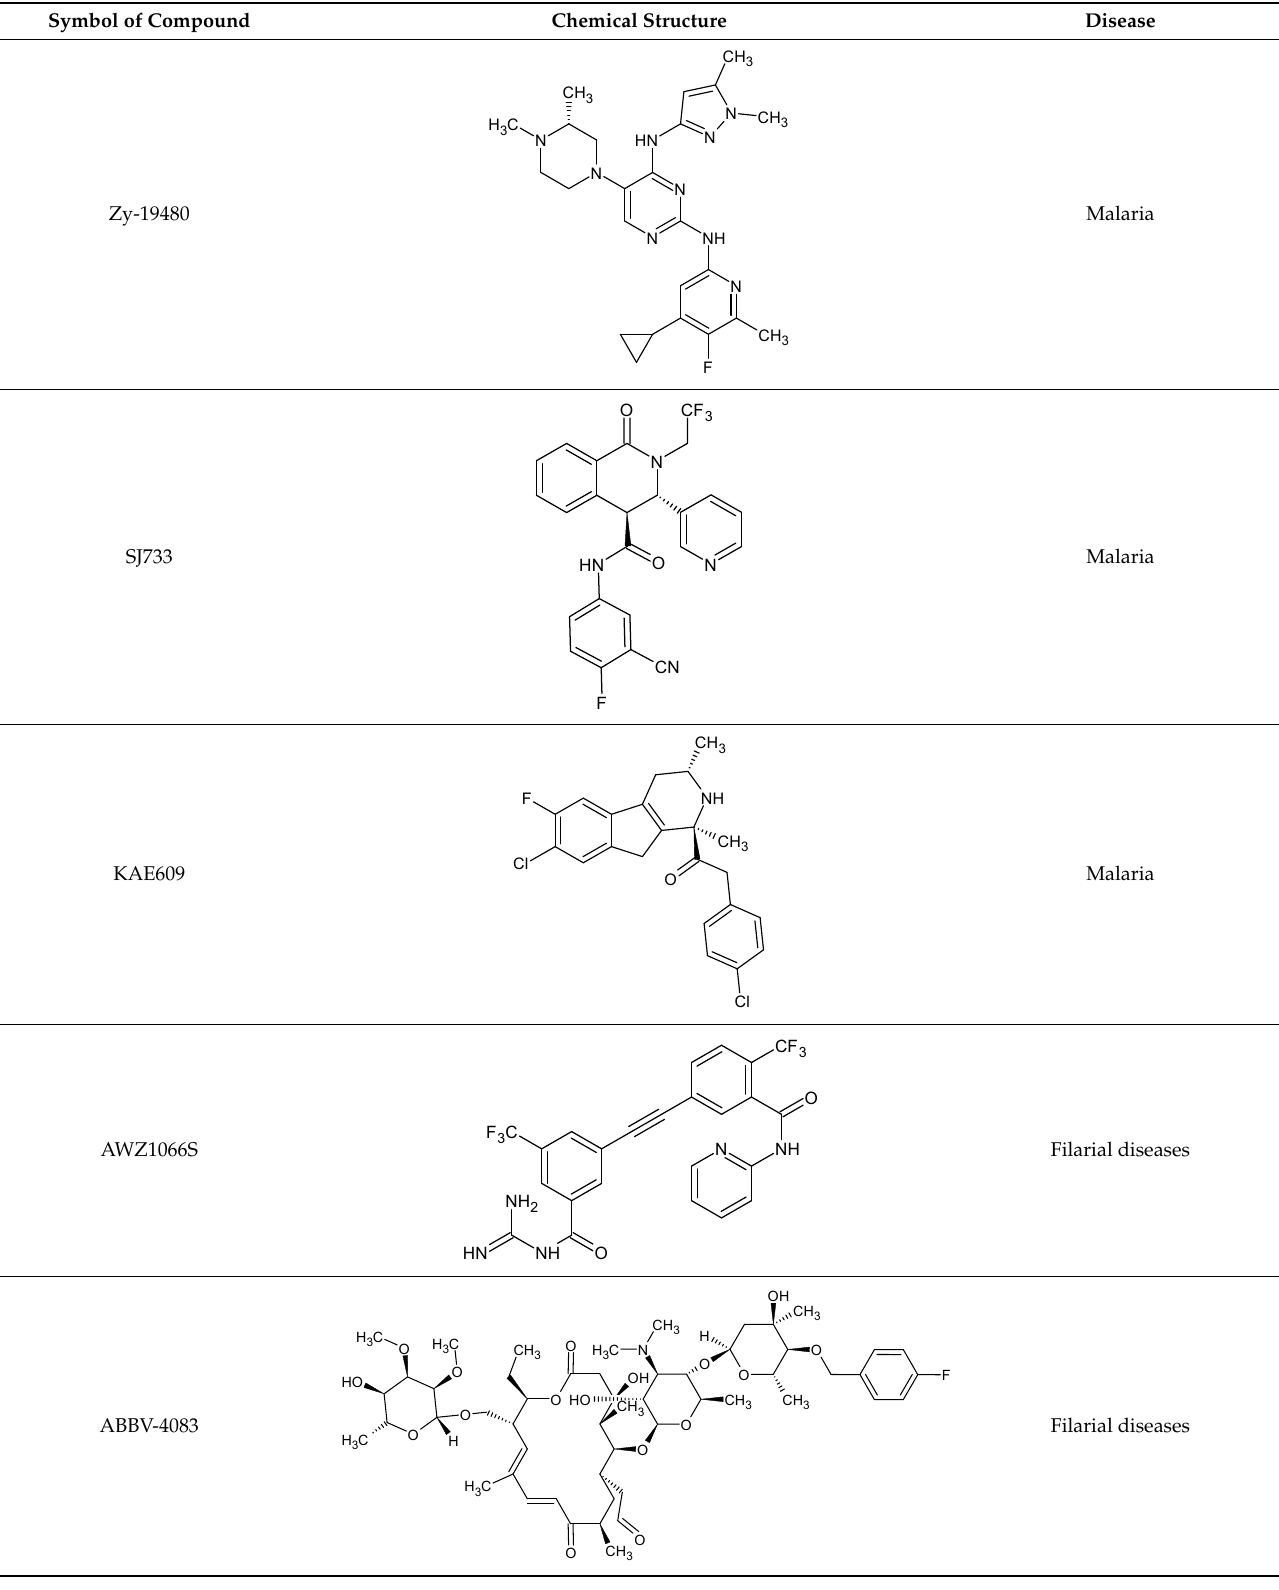
Table 3. The structure of new antiparasitic compounds in clinical trials.